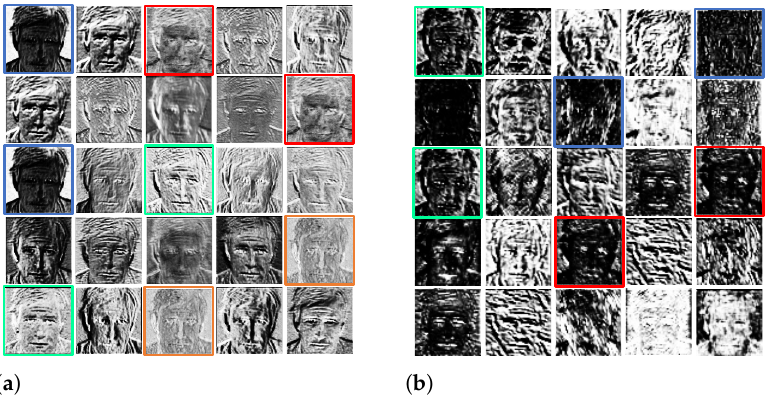
Figure 1. Visualization of the different layers of VGG-16, where similar features are annotated with the boxes of the same color: ( a ) 5th layer of VGG-16 and ( b ) 10th layer of